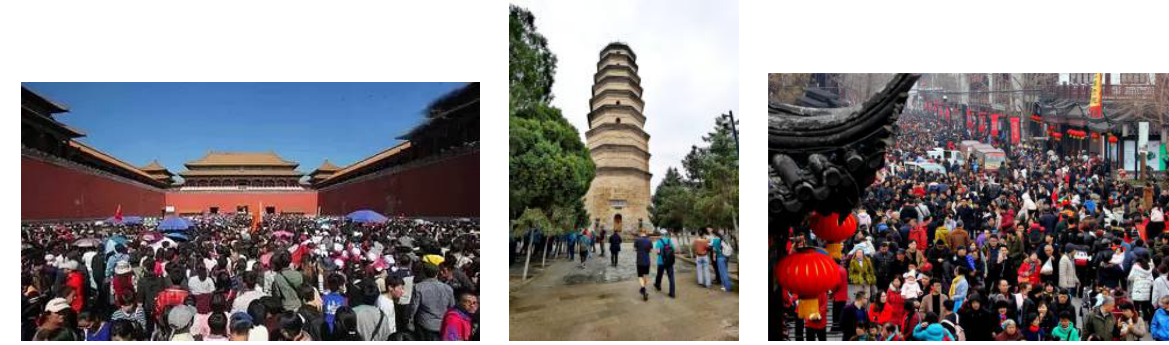
Fig. 1. Crowd scene